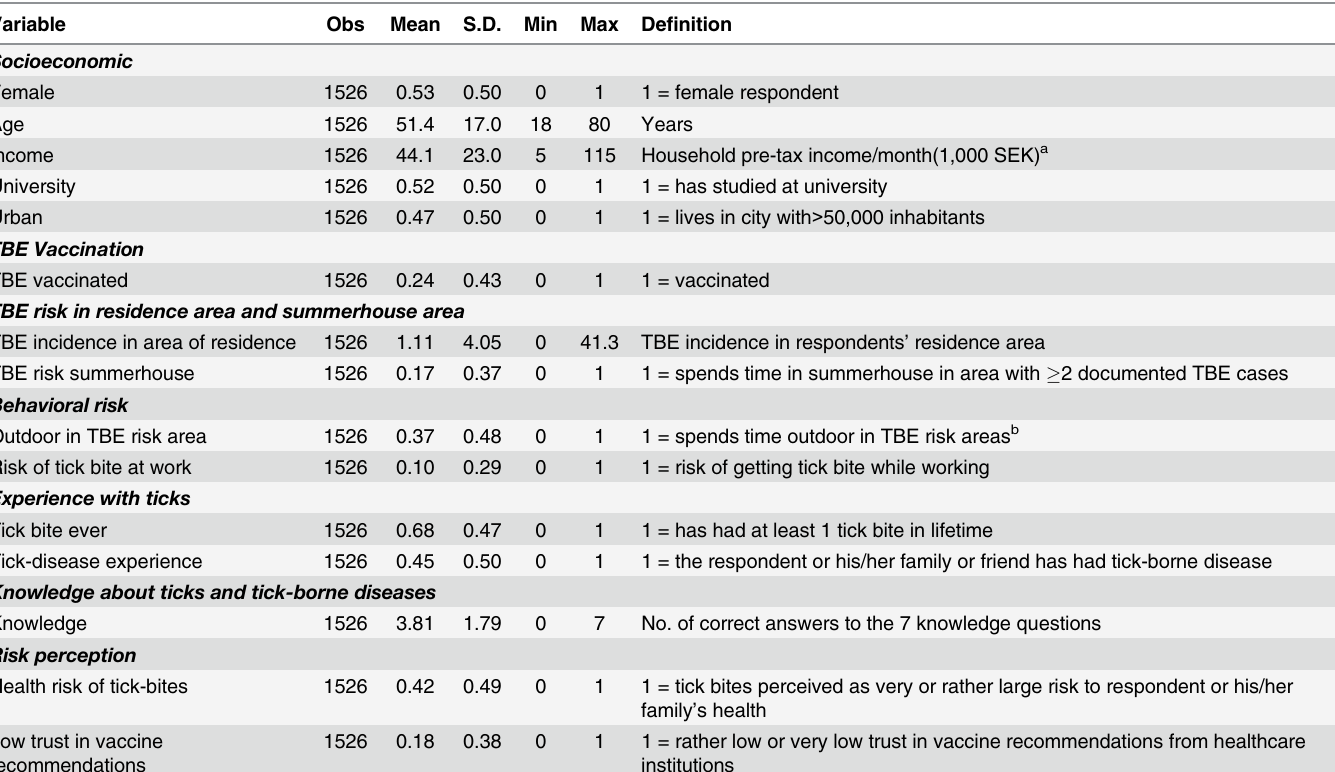
Table 1. Variable definitions and summary